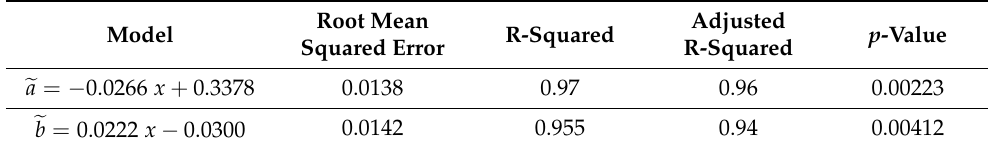
Table 7. Vector ˆ B sp